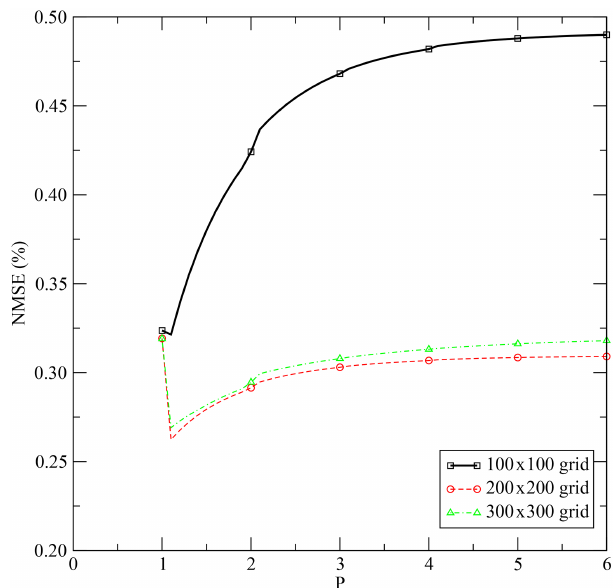
Figure 4. Evolution of performance based on the NMSE for the three cases as a function of the parameter p of the p -distance com-